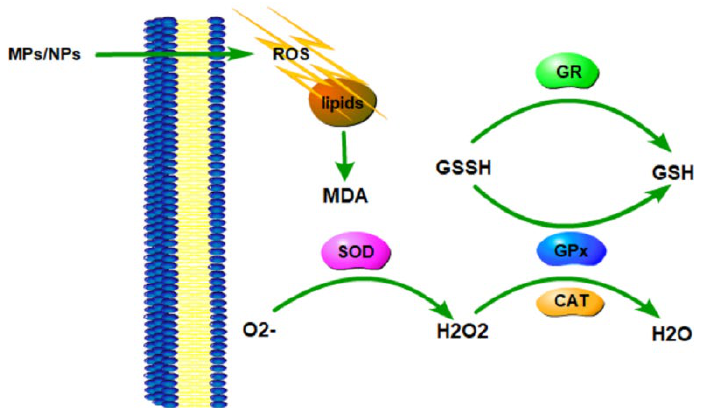
Figure 2. Schematic diagram of MPs/NPs-mediated oxidative stress response.